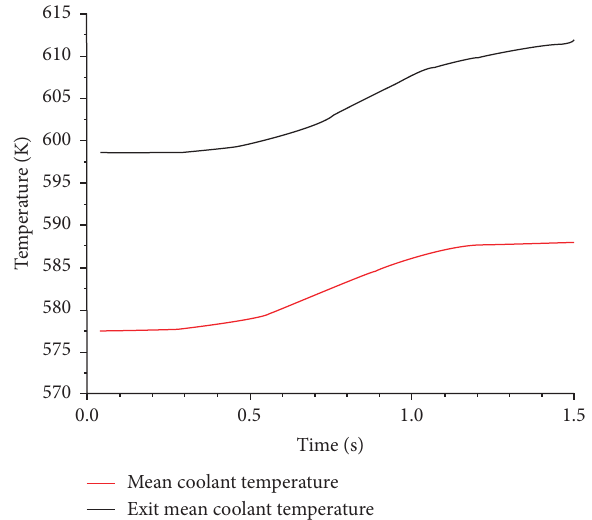
Figure 8: The mean and exit mean coolant temperature for the fast